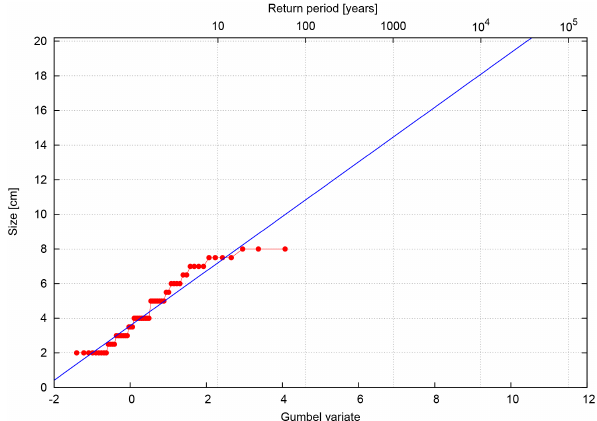
Figure 8. Maximum observed hail size (one value per year, mini- mum value 2cm) from Finland (Tuovinen et al., 2009) in relation to return times, using a Gumbel